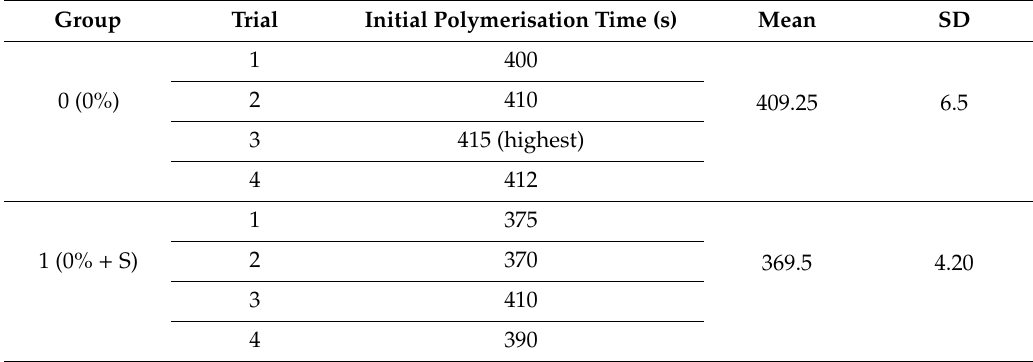
Table 5. Characteristics of groups during the initial polymerisation time test.